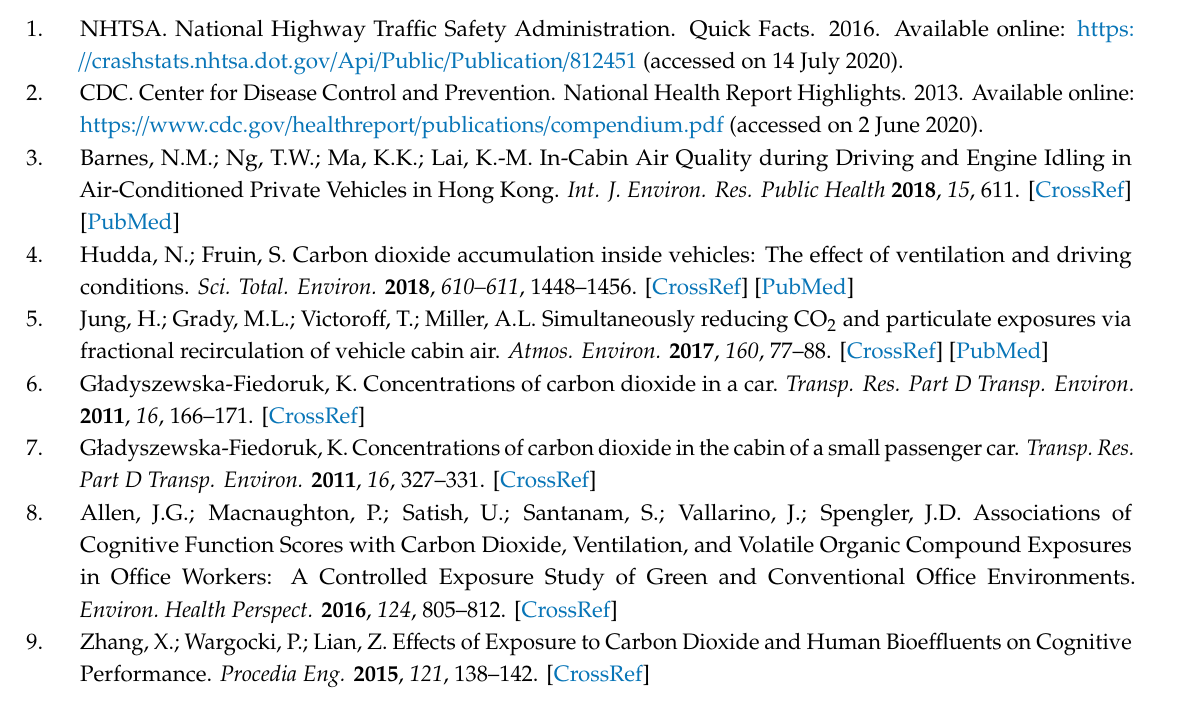
Figure S1: Temperature, relative humidity (RH), and CO 2 concentrations versus time within a car while driving with the ventilation system closed, and the driver breathing in and out of the car cabin via a tubing system that preclude from exhale carbon dioxide buildup; Figure S2: Raw CO 2 monitor results together with real-time speed log for condition #1; Figure S3: Raw CO 2 monitor results together with real-time speed log for condition